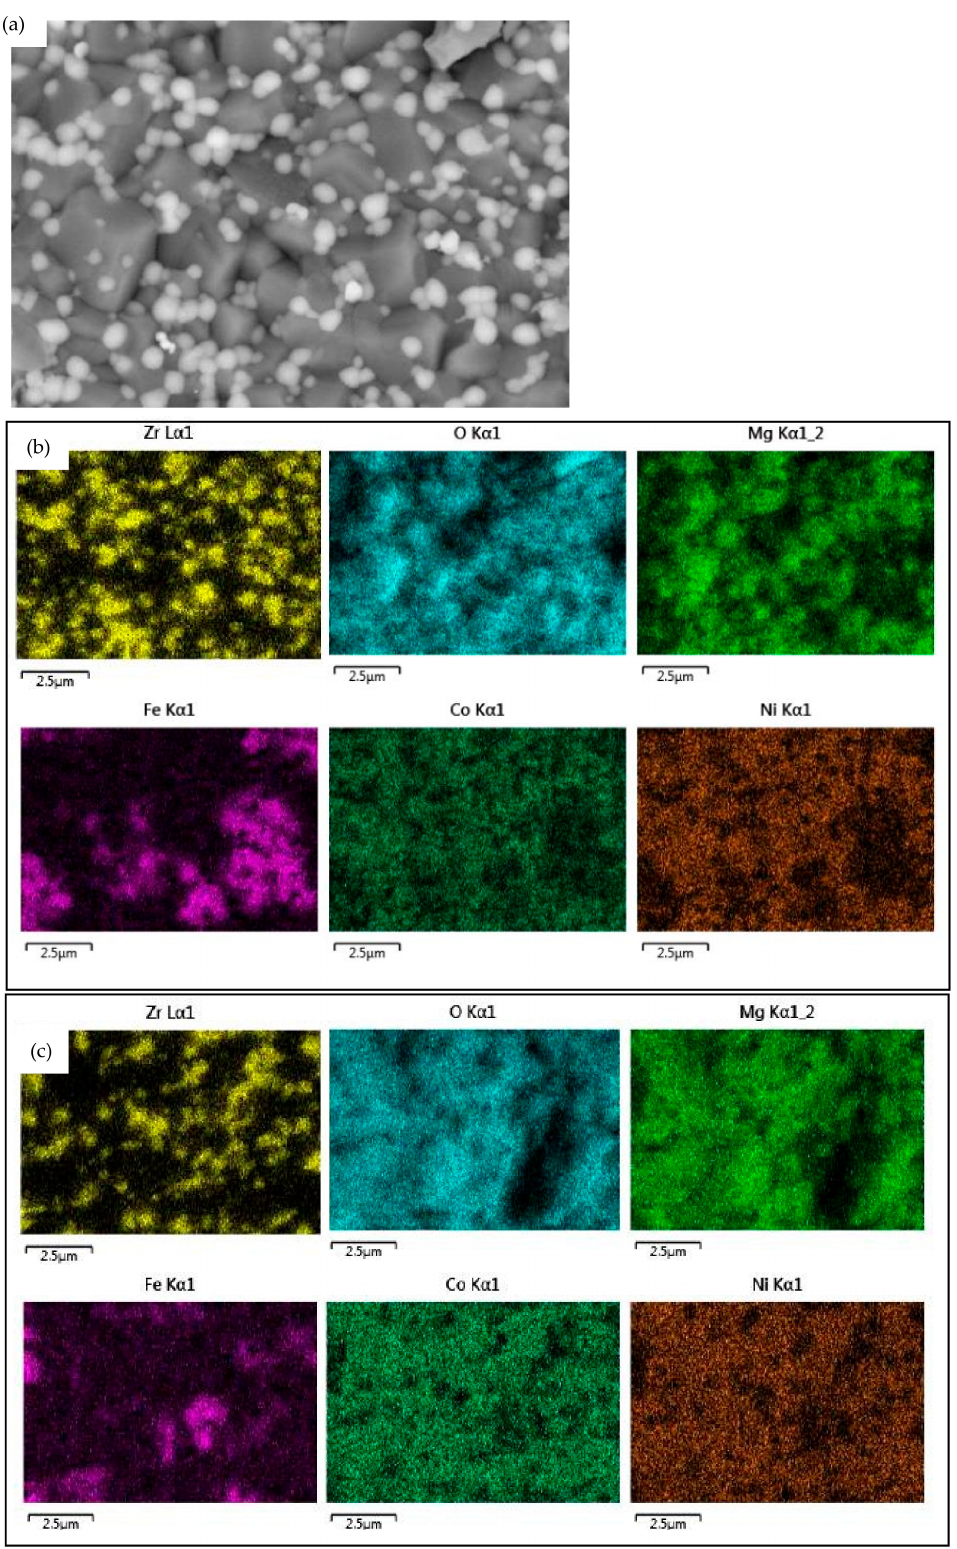
Figure 3. EDS analysis of HEO 2. ( a ) SEM analysis of HEO 2 after annealing at 1300 ◦ C. ( b ) Elementary cartography after annealing in air at 1300 ◦ C, and ( c ) after thermochemical